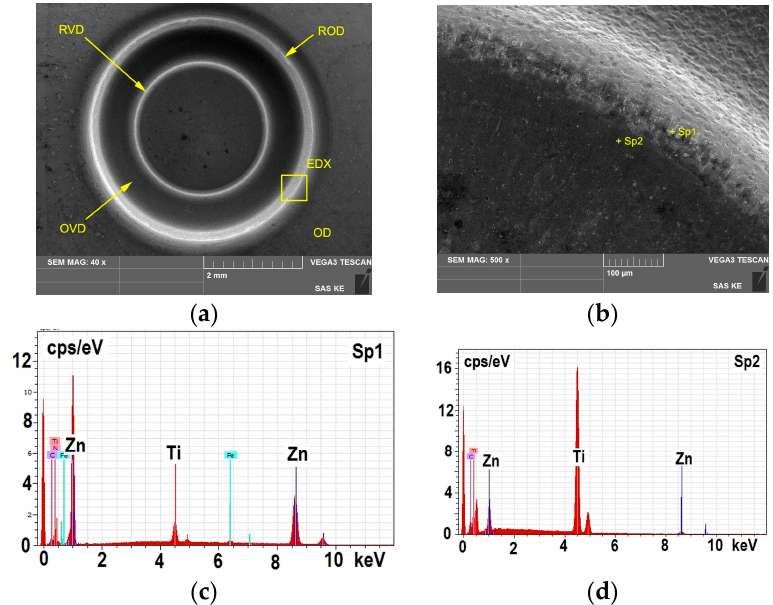
Figure 15. TiCN MP die-defect in the radius surrounding the cavity of the shaped surface he radius of the surrounding of the cavity (ROD): ( a ) wear disposition of the shaped part of the die; ( b ) detail of ROD; ( c ) EDX microanalysis of Sp1 area; ( d ) EDX microanalysis of Sp2 area.